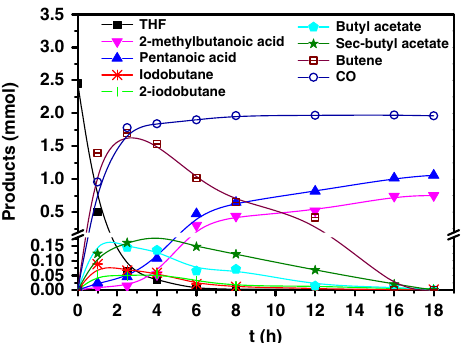
Fig. 3 Time course of the reaction. Reaction conditions: 20 μ mol IrI 4 , 2 mmol LiI, 0.6 mL AcOH, 2.45 mmol THF, 5 MPa CO 2 (68 mmol) and 2 MPa H 2 (at room temperature), 170 °C.